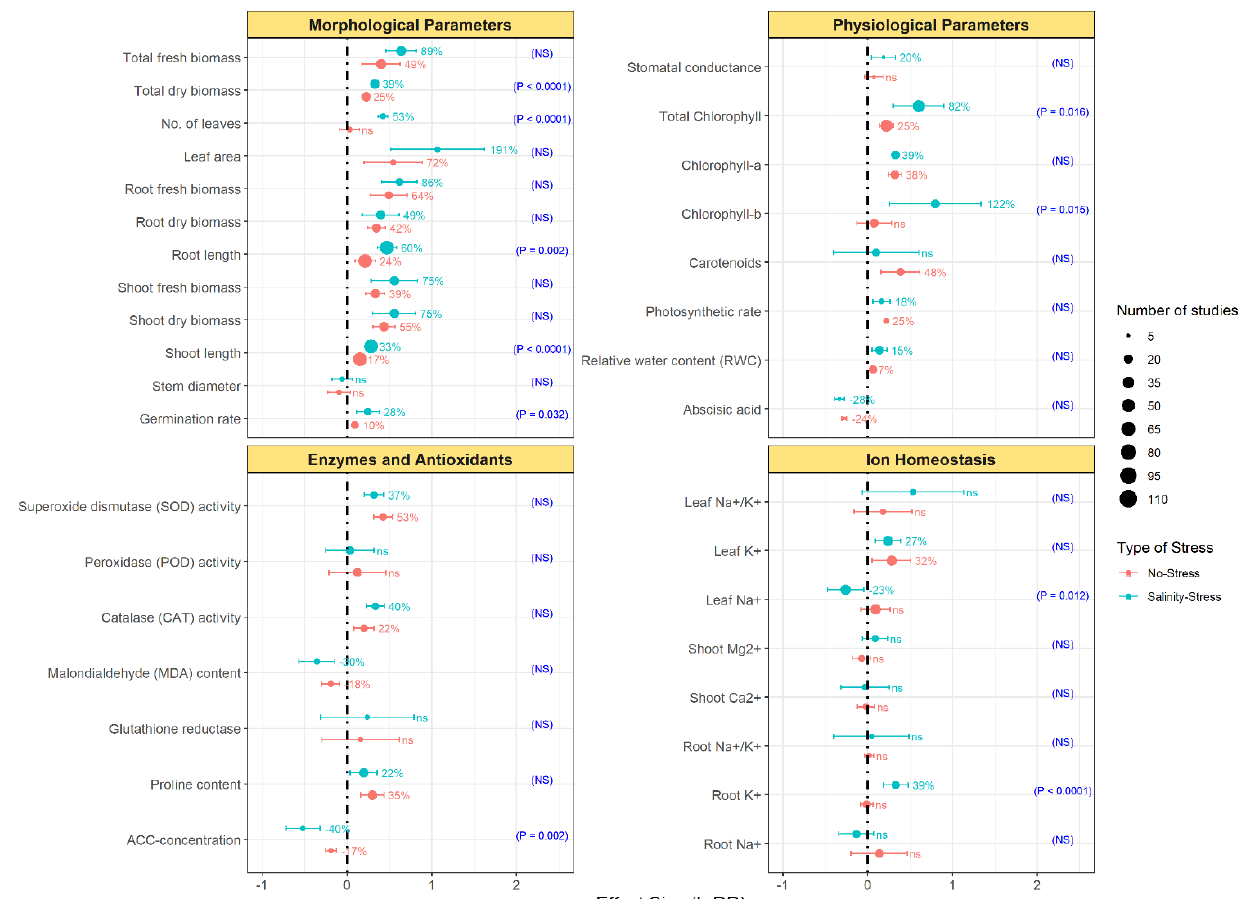
Figure 2. Effect of endophytic bacterial inoculation on morphological parameters, physiological parameters, enzymes and antioxidants, and ion homeostasis under no-stress and salinity-stress conditions. Error bars represent 95% confidence intervals (CIs). The inoculation effects were considered significant if the 95% CIs did not overlap with the zero line. The size of the scatter point shows the number of experimental observations. p - values and ‘NS’ in parenthesis show the significant and non-significant differences, respectively, between growth conditions.